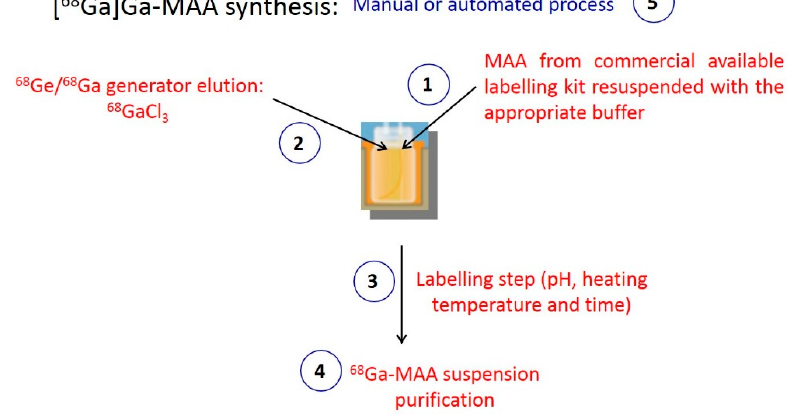
Figure 1. Key points of MAA labelling with 68 Ga.